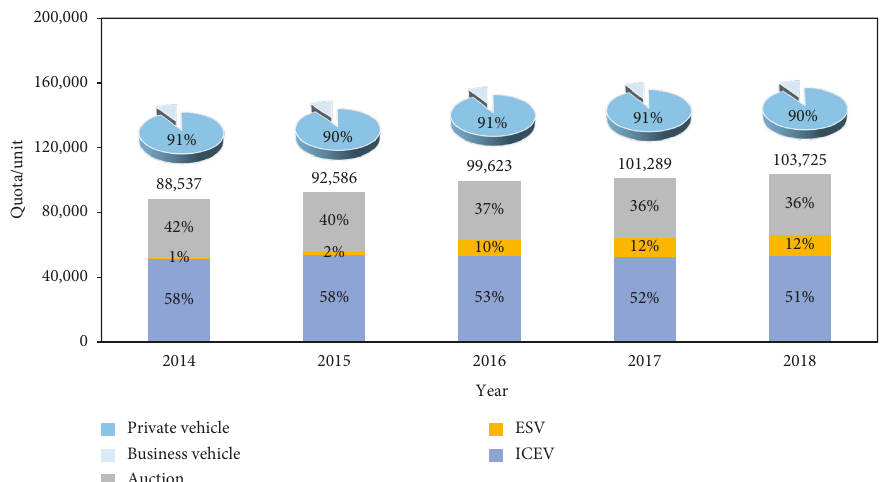
Figure 5: The number of plates issued every year in Tianjin under purchase restriction policies.